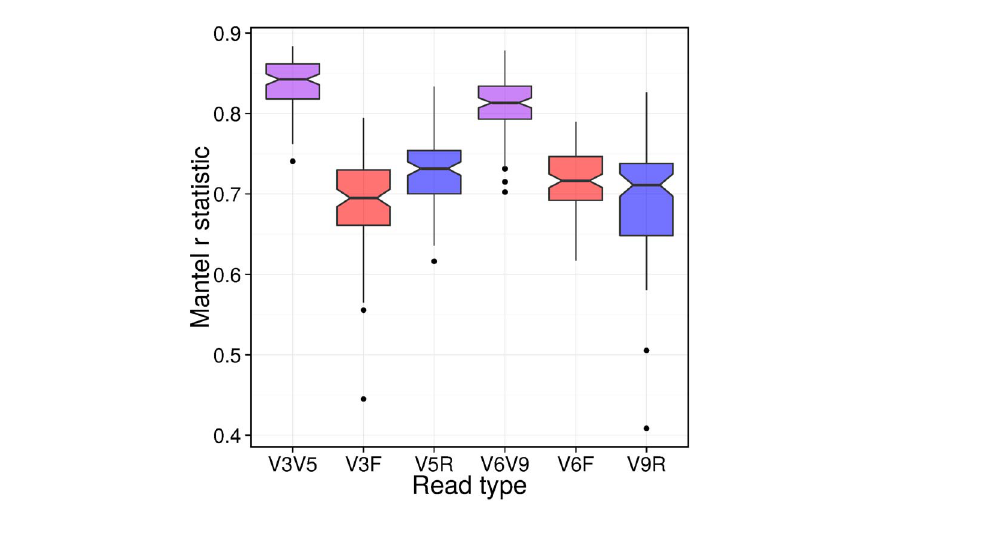
Fig. 2. Comparison of phylogenetic trees between libraries. Plot of a Mantel correlation test comparing cophenetic distance matrices calculated from phylogenetic trees created using paired, R1 and R2 (for both the V3–V5 and V6–V9 primer pairs) versus the distance matrix created from the corresponding full-length 16S trees. A higher correlation value means the trees are more closely related to the full-length trees. Here, the paired trees are significantly closer to the full-length trees than the R1 and R2 trees ( p , 0.0001, Wilcoxon signed ranked test, using 100 synthetic mock communities), strongly suggesting that combining the use of paired reads leads to phylogenies closer to what is obtained from full-length reads, even when the chosen primers create non-overlapping